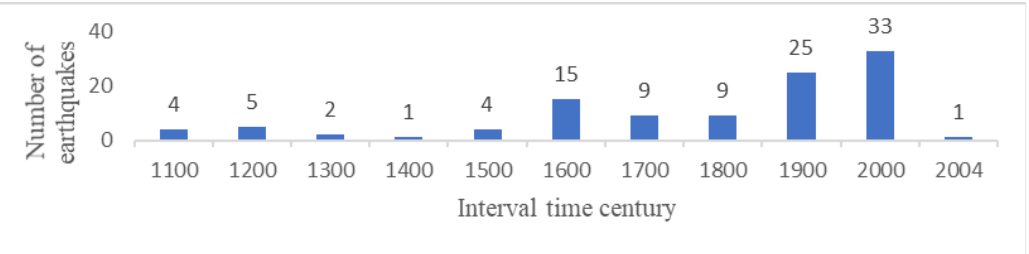
Figure 2. Breakdown of the earthquakes, beginning with 984, M w ≥ 6. Source: ROMPLUS Catalogue (2021).